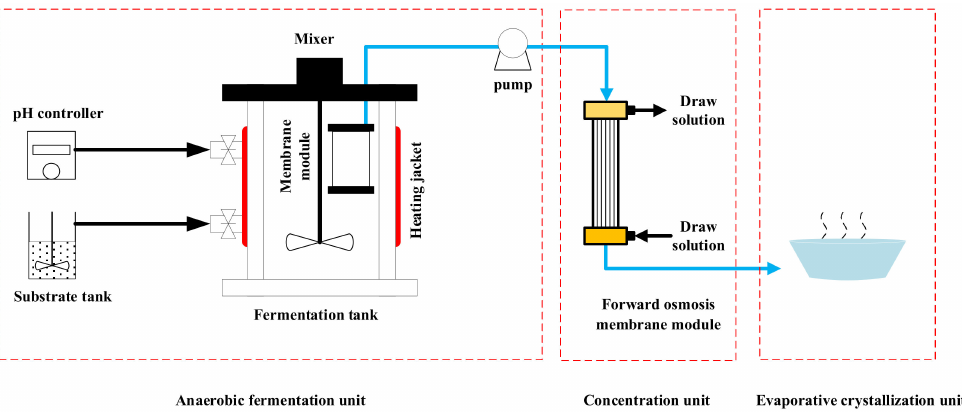
Figure 1. Schematic illustration of the novel fabrication processes for